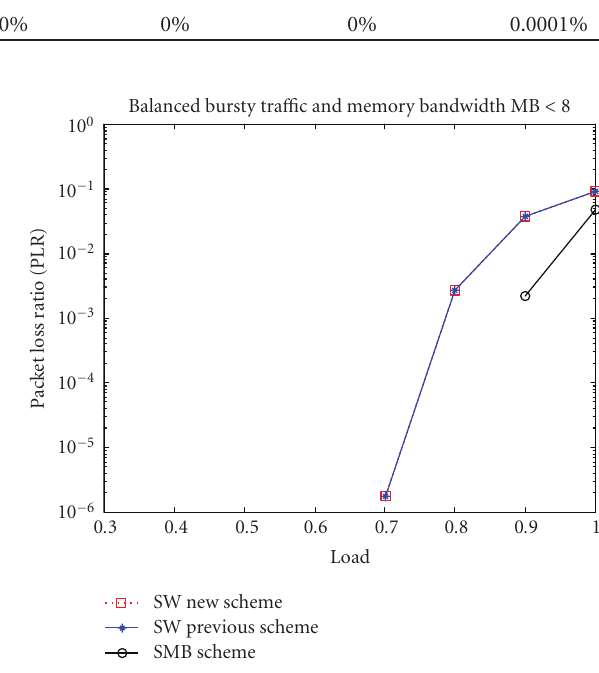
Figure 4: Average throughput with speed-up of memory modules. Figure 5: Packet-loss ratio with speed-up of memory